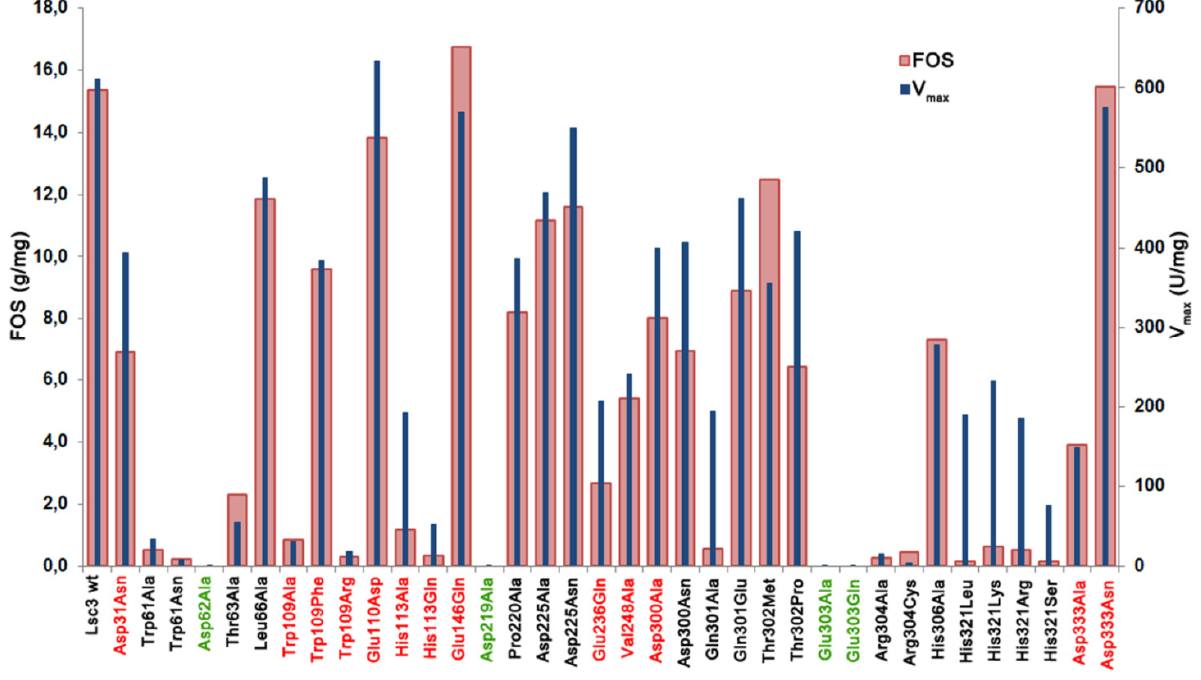
Figure 5. The amount of total FOS (g/mg of protein) produced from 1.2 M sucrose in a 20 h reaction by purified wild-type Lsc3 and thirty six mutant proteins. Mutants of catalytic triad positions are shown in green and the mutants studied in this work for the first time are (U/mg) of sucrose-splitting reaction is plotted for comparison. Mean values of in red. V max at least two independent experiments are shown. Standard deviation was less than